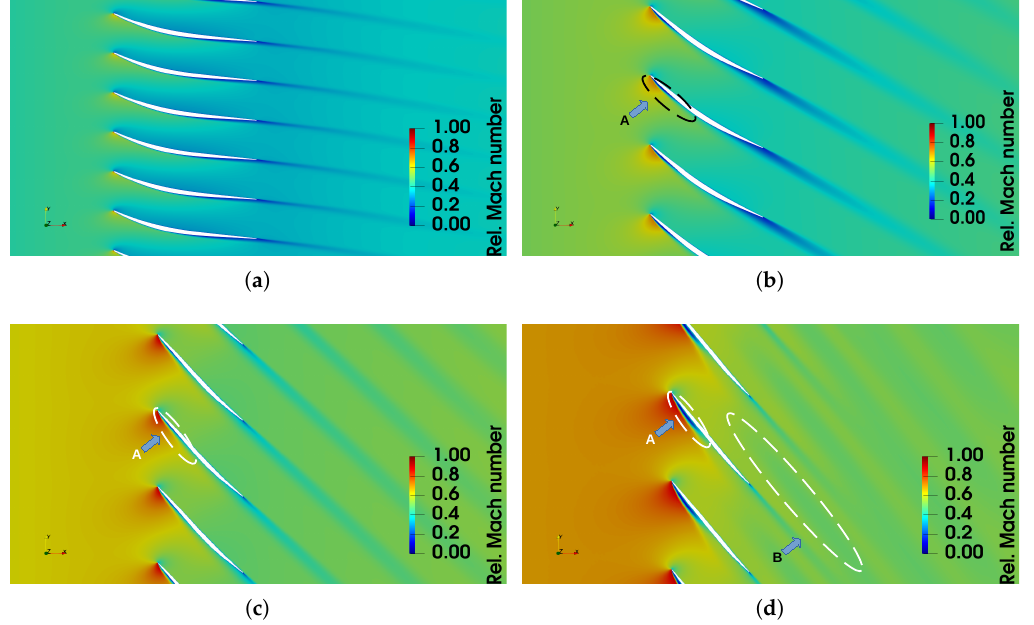
Figure 7. Relative Mach number contours at different spanwise positions: ( a ) 25%; ( b ) 50%; ( c ) 75%; ( d )